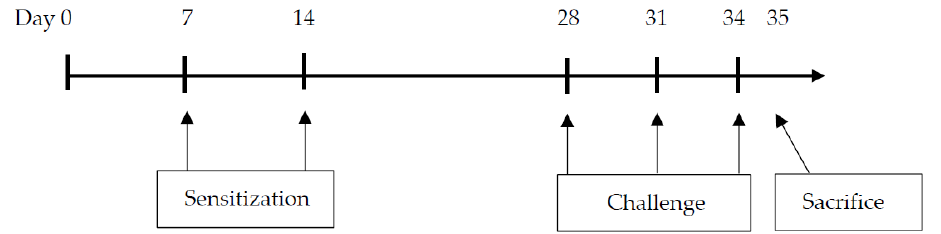
Figure 1. Experimental protocol. All mice were sacrificed on day 35 (24 h after the last challenge).